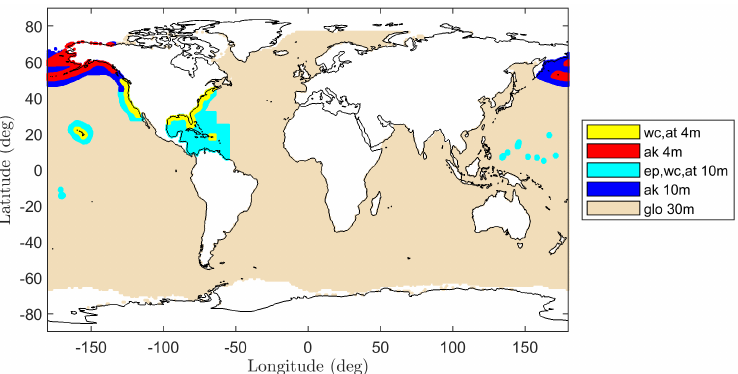
Figure 5. WW3 MultiGrid spatial resolution map; 4, 10, and 30 arc-min regions are shown using yellow/red, light/dark blue, and light-gray colors, respectively. See [51] for additional details.